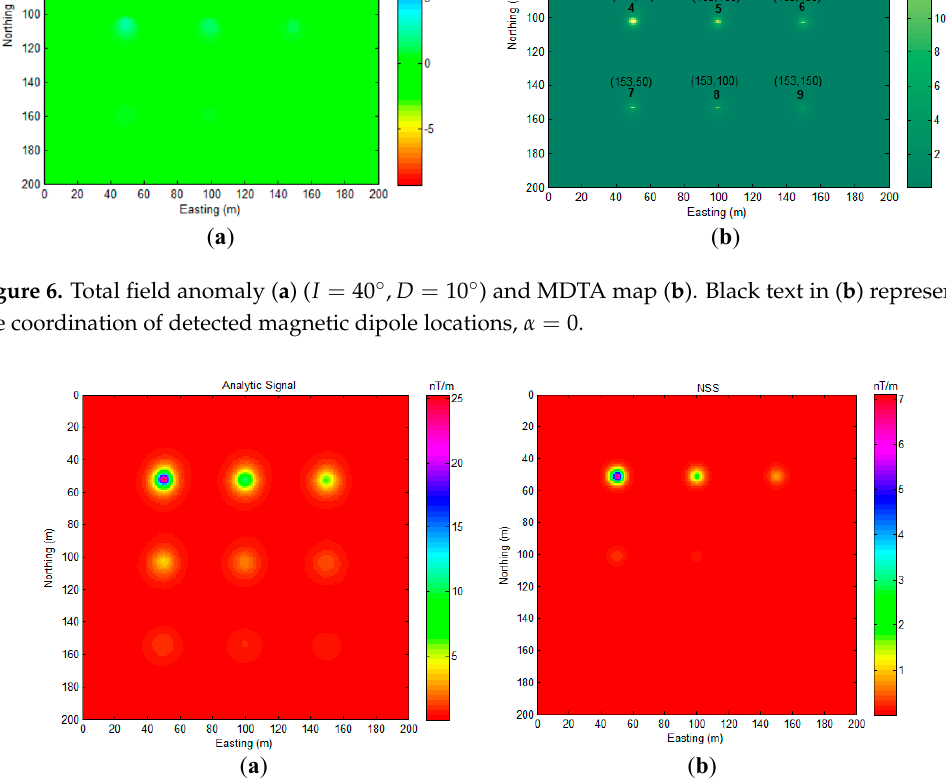
( a ) ( a ) ( b ) ( a ) ( b ) Figure 7. ( a ) Analytic signal (ASS); and, ( b ) Normalized Source Strength (NSS) [11] . Figure 7. ( a ) Analytic signal (ASS); and, ( b ) Normalized Source Strength (NSS) [11] . Figure 7. ( a ) Analytic signal (ASS); and, ( b ) Normalized Source Strength (NSS) [11]. Figure 7. ( a ) Analytic signal (ASS); and, ( b ) Normalized Source Strength (NSS) [11] .